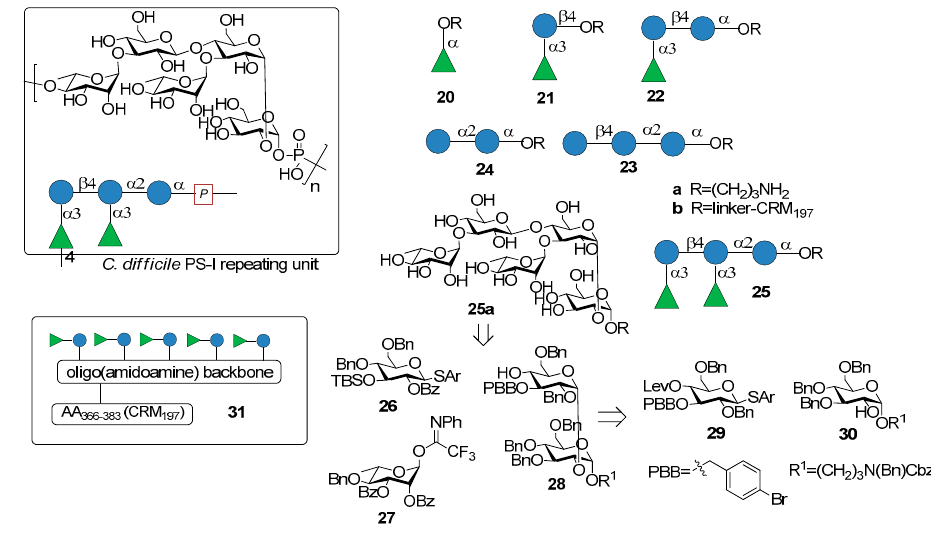
Figure 3. C. difficile PS-I repeating unit, synthetic fragments 20 – 25 and retrosynthetic analysis reported in [29].